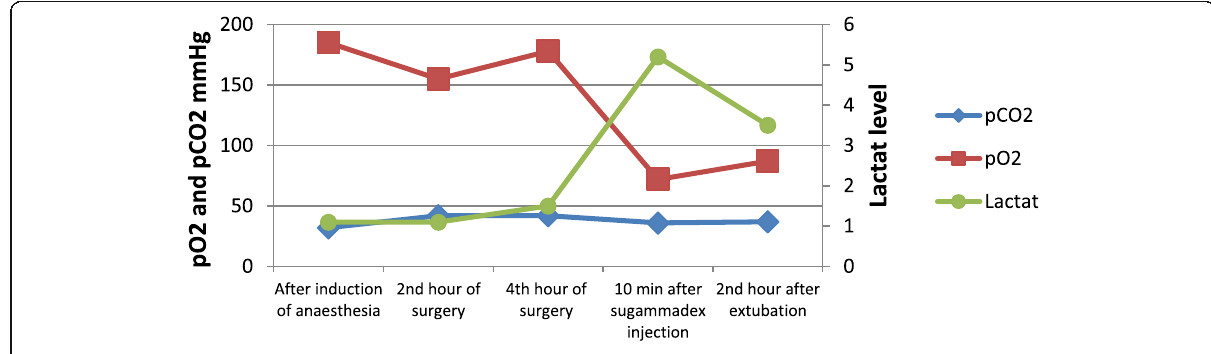
Fig. 3 Arterial blood gas sample